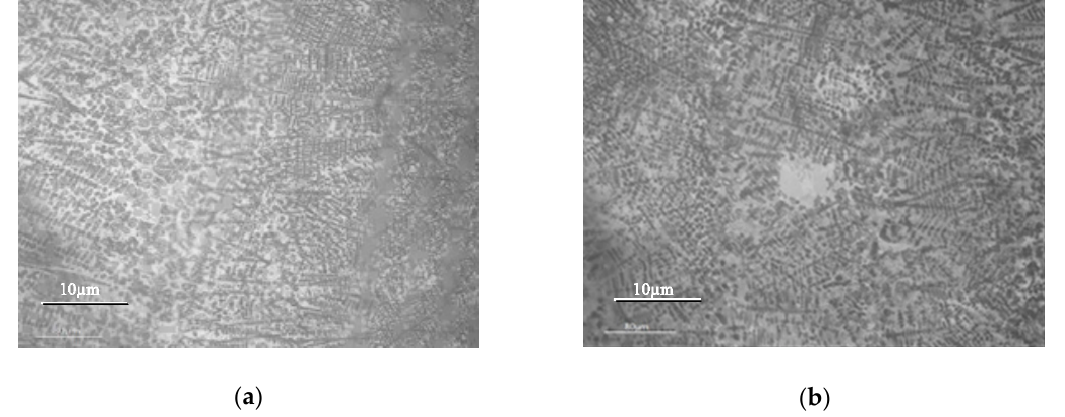
Figure 2. Microstructures of the coatings before and after laser re-melting. ( a ) cladding coating of WC/Fe, ( b ) re-melting of WC/Fe.